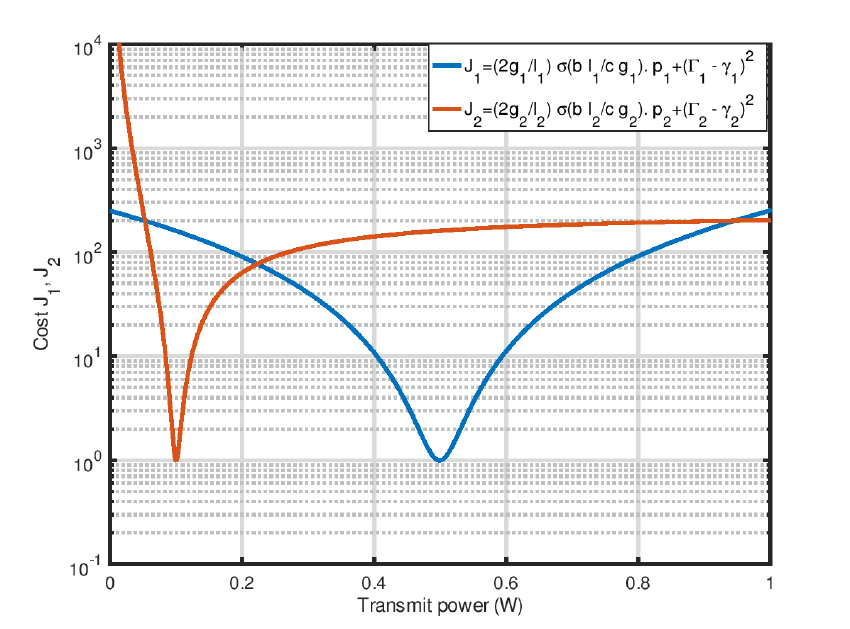
Figure 2. Cost function of D2D transmitter and cellular user as a function of transmit